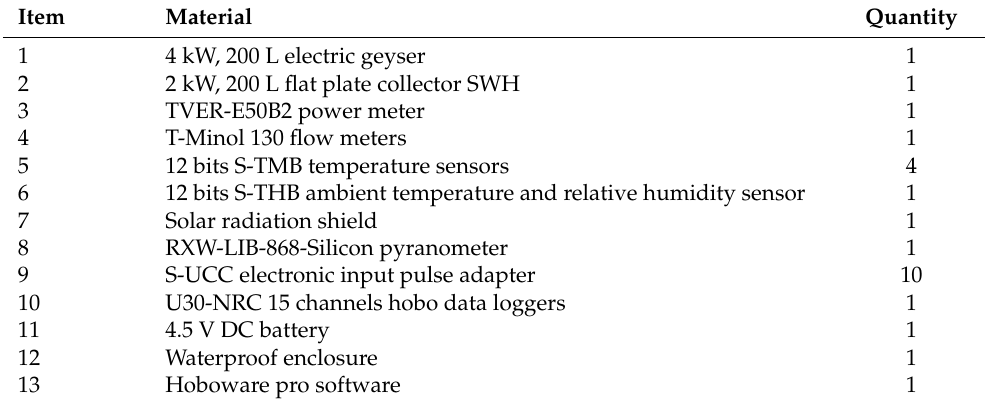
Table 1. List of materials for the experimental setup.